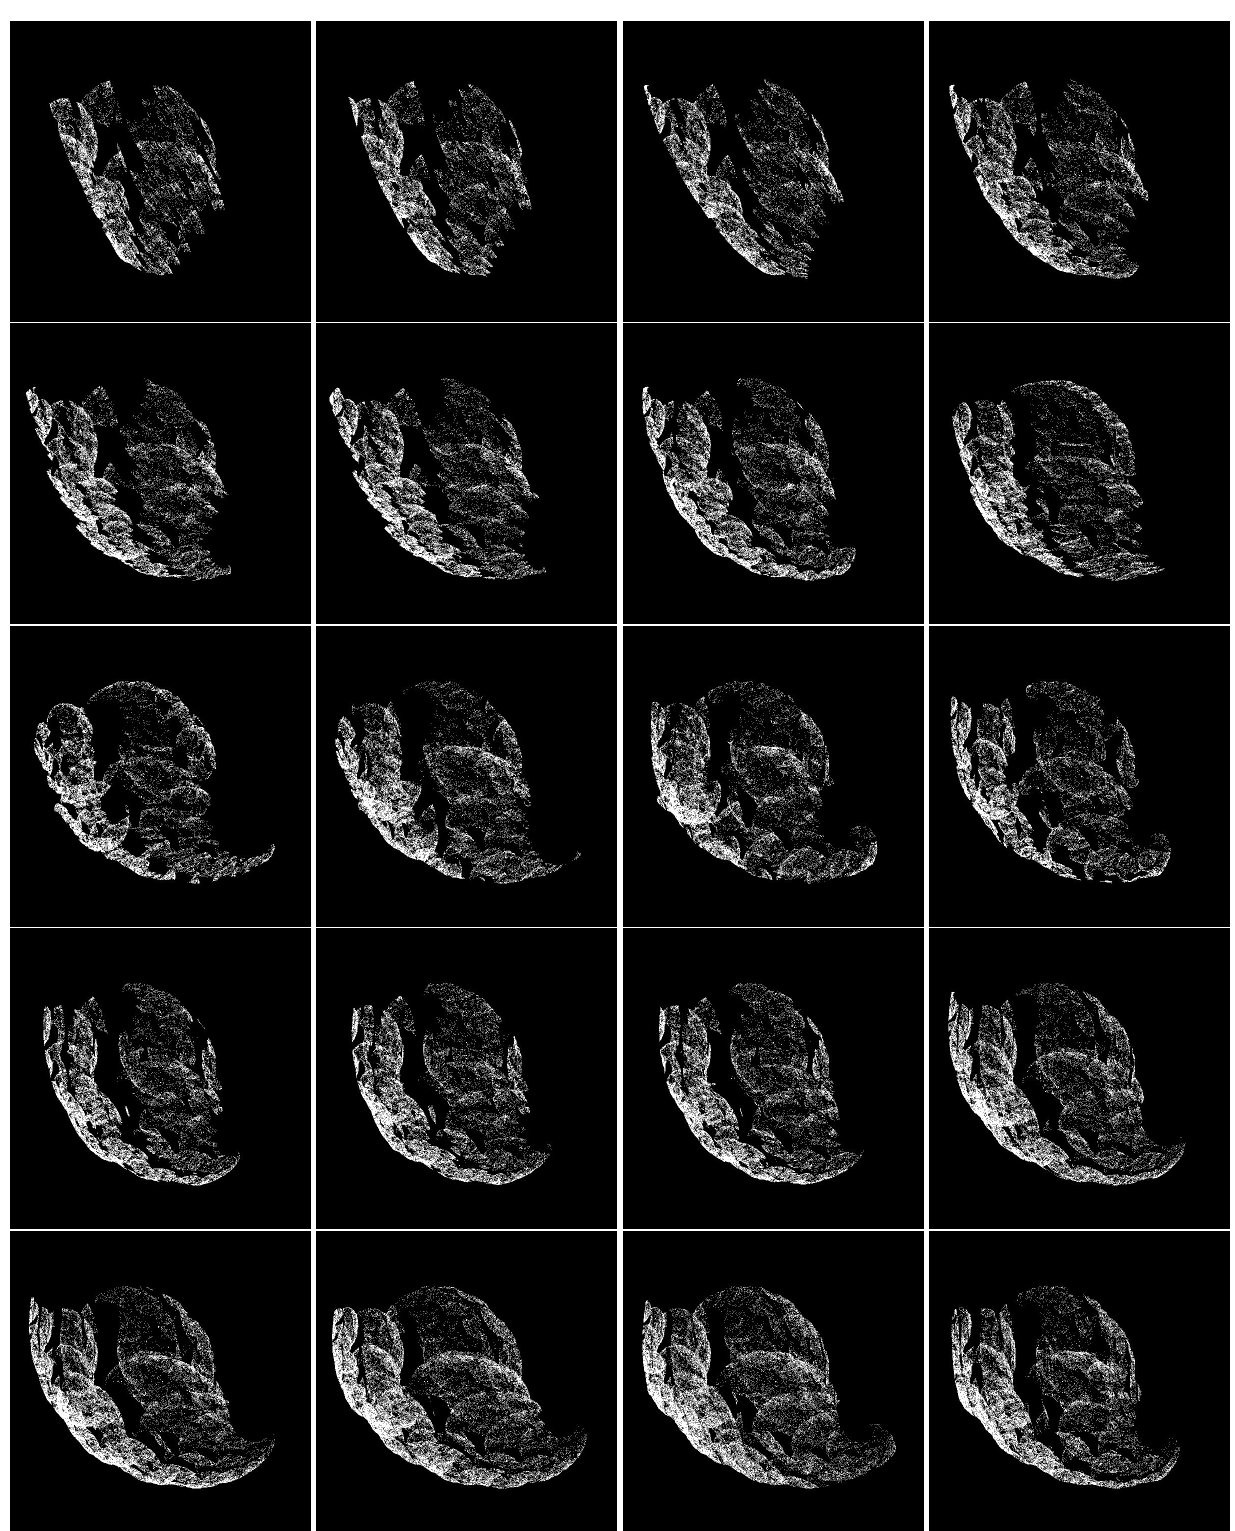
Figure 8. ( left – right , top – bottom ): Evolution of the intersection between the original and the recon- structed images for 400–780 iterations (step size, 20